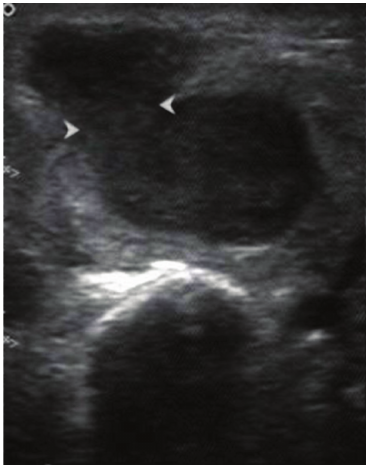
Figure 1: The left parotid. Small well-defined hypoechoic lesions (arrowheads) are seen within the parenchyma of the relatively hy- perechoic left parotid gland.